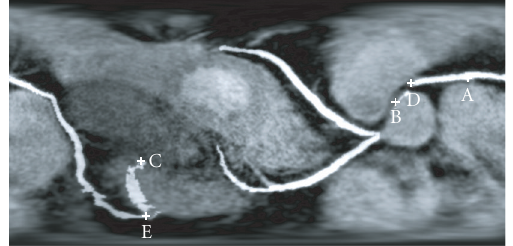
Figure 3: Landmark A is initially manually placed inside the ves- sel. Landmarks B and C are automatically placed by the algorithm. Vessel end points D and E are manual corrections of points B and C which are placed on the curved view without the need to scroll through multiple